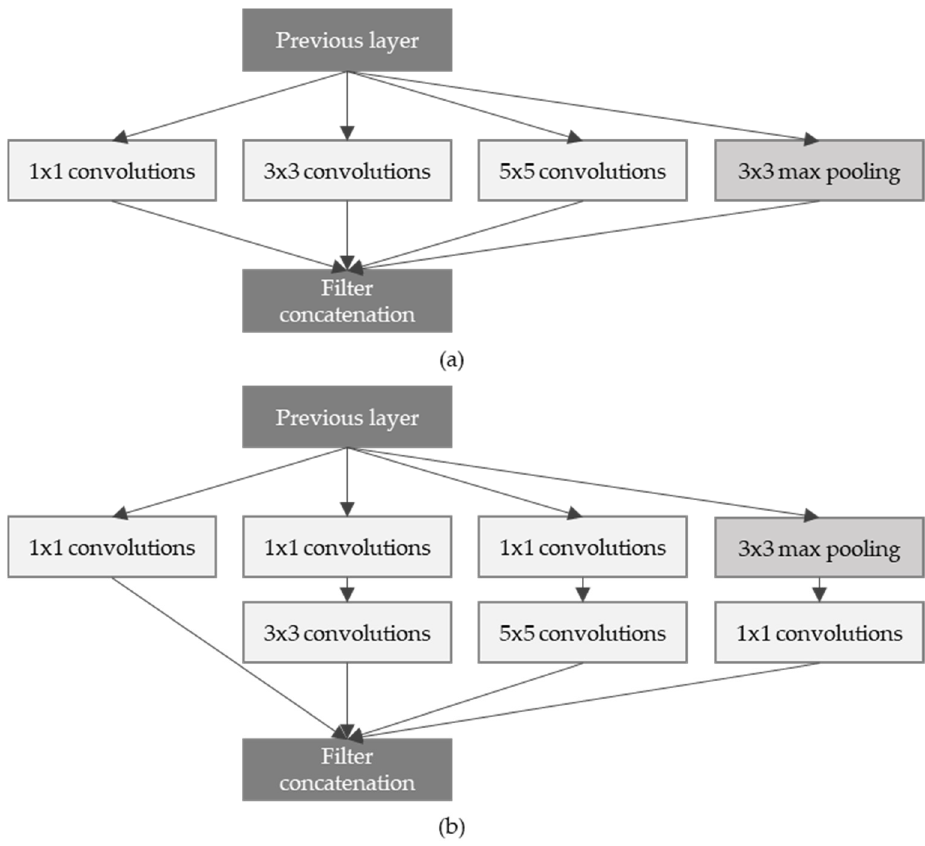
Figure 2. ( a ) Architecture of Inception module in the naïve version, ( b ) Architecture of Inception with dimensionality reduction in the Inception module.